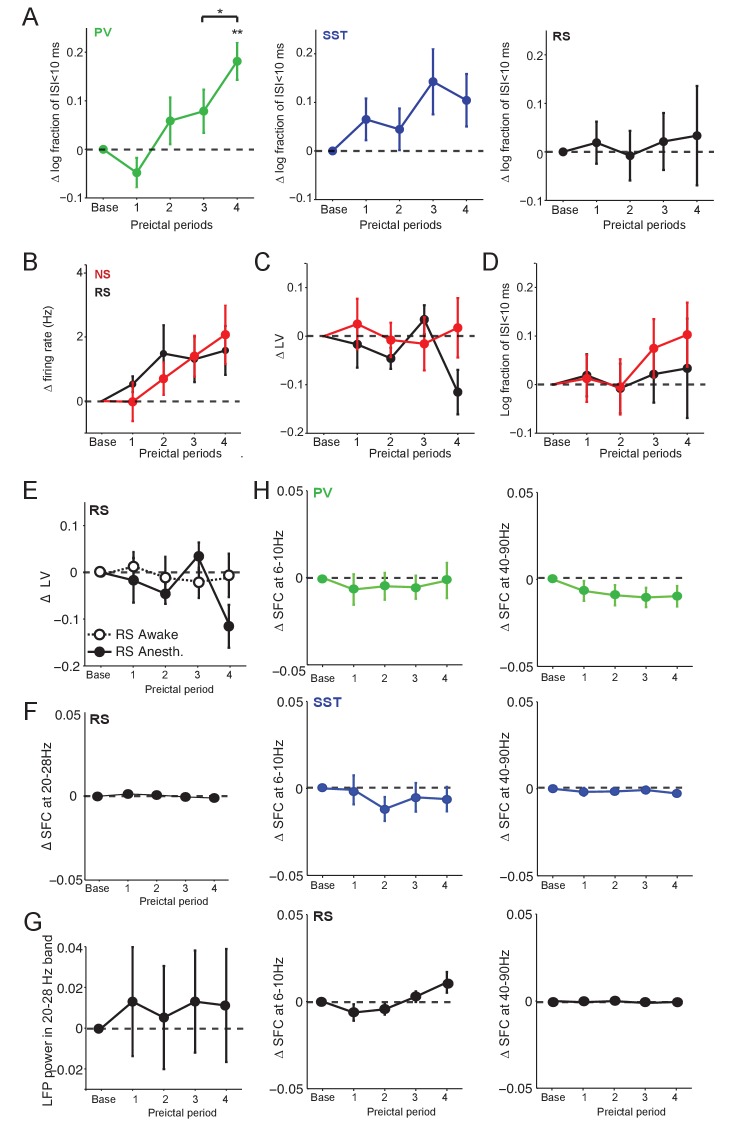
Preictal changes in the temporal pattern of interneuron activity.(A) Mean ±SEM changes in the log10-ratio of short inter-spike-intervals (ISI;<10 ms) over long ISI (>10 ms) intervals, comparing baseline to four preictal periods for PV, SST and RS cells in acute PTZ seizure. **p<0.0025 for statistical comparisons to baseline. (B) A subset of the unidentified, ChR2-negative cells exhibited narrow spiking waveforms. Mean ±SEM changes in firing rate as compared to baseline over four preictal periods for RS cells (n = 20 cells in 12 mice) and the non-identified cells with narrow spike (NS) waveforms (n = 19 cells in 12 mice; see Figure 1—figure supplement 1) in the acute PTZ seizure model. See Figure 1E for comparison. (C) Mean ±SEM changes in local variation (LV) of firing as compared to baseline over four preictal periods for putative RS and NS cells. See Figure 4A for comparison. (D) Mean ±SEM changes in the log10-ratio of short inter-spike-intervals (ISI;<10 ms) over long ISI (>10 ms) intervals, comparing baseline to four preictal periods for RS cells and NS cells. (E) Change in LV of firing for RS cells over the four preictal periods in anesthetized and awake mice. See Figure 4A–B for comparison. (F) Quantification of spike-field coherence (SFC) for RS cells with the 20 – 28 Hz low gamma band during the four preictal periods as compared to baseline. See Figure 4D for comparison. (G) Mean ±SEM modulation in LFP power in different preictal periods as compared to baseline in the 20 – 28 Hz band for acute PTZ seizure. Modulation of LFP power was quantified as the log-ratio of LFP power during a preictal period over the LFP power during baseline. (H) Quantification of spike-field coherence (SFC) for PV (upper, green), SST (middle, blue), and RS (lower, black) cells with the theta (6 – 10 Hz, left) and high gamma (40 – 90 Hz, right) LFP bands. None of the comparisons to baseline (dotted lines) reached significance at p<0.0125.